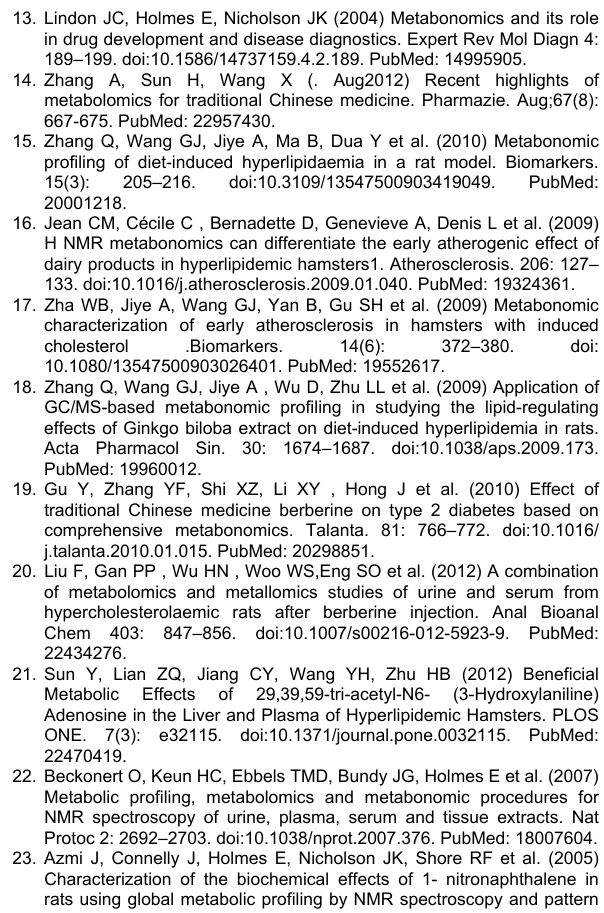
Table S1. 1 H Chemical shift assignment of the metabolites in plasma and liver of rats.